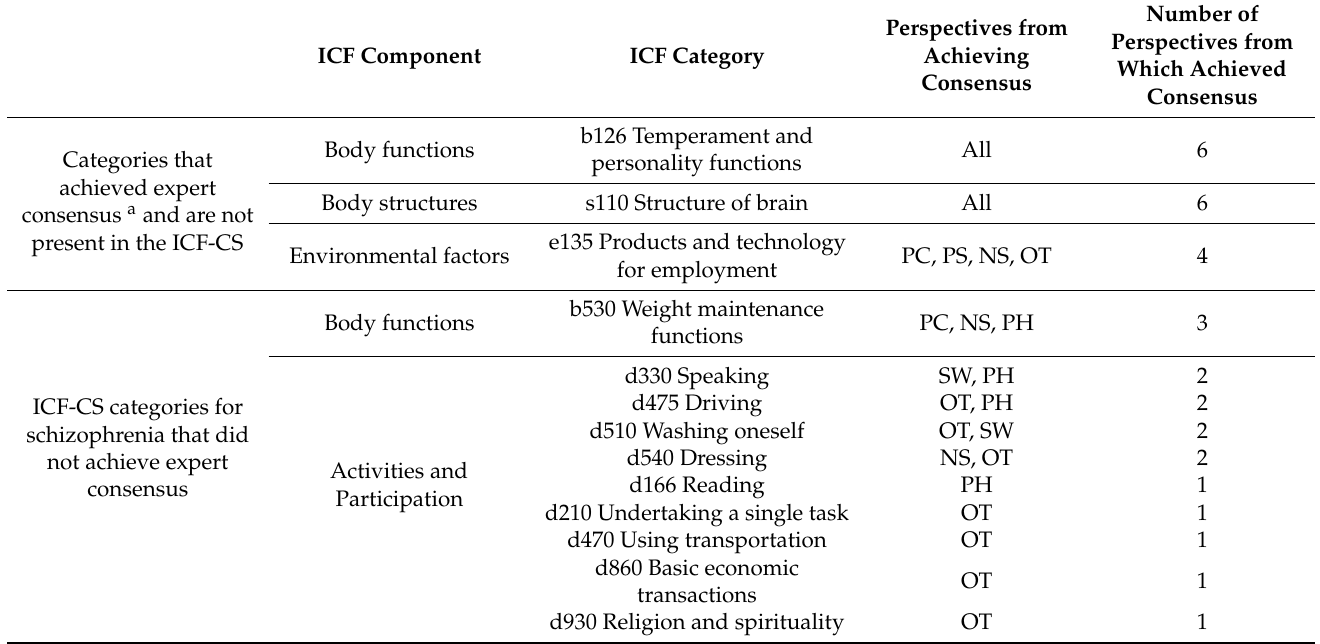
Table 3. Categories that did not match between the set of categories that achieved expert consensus and the ICF-CS for